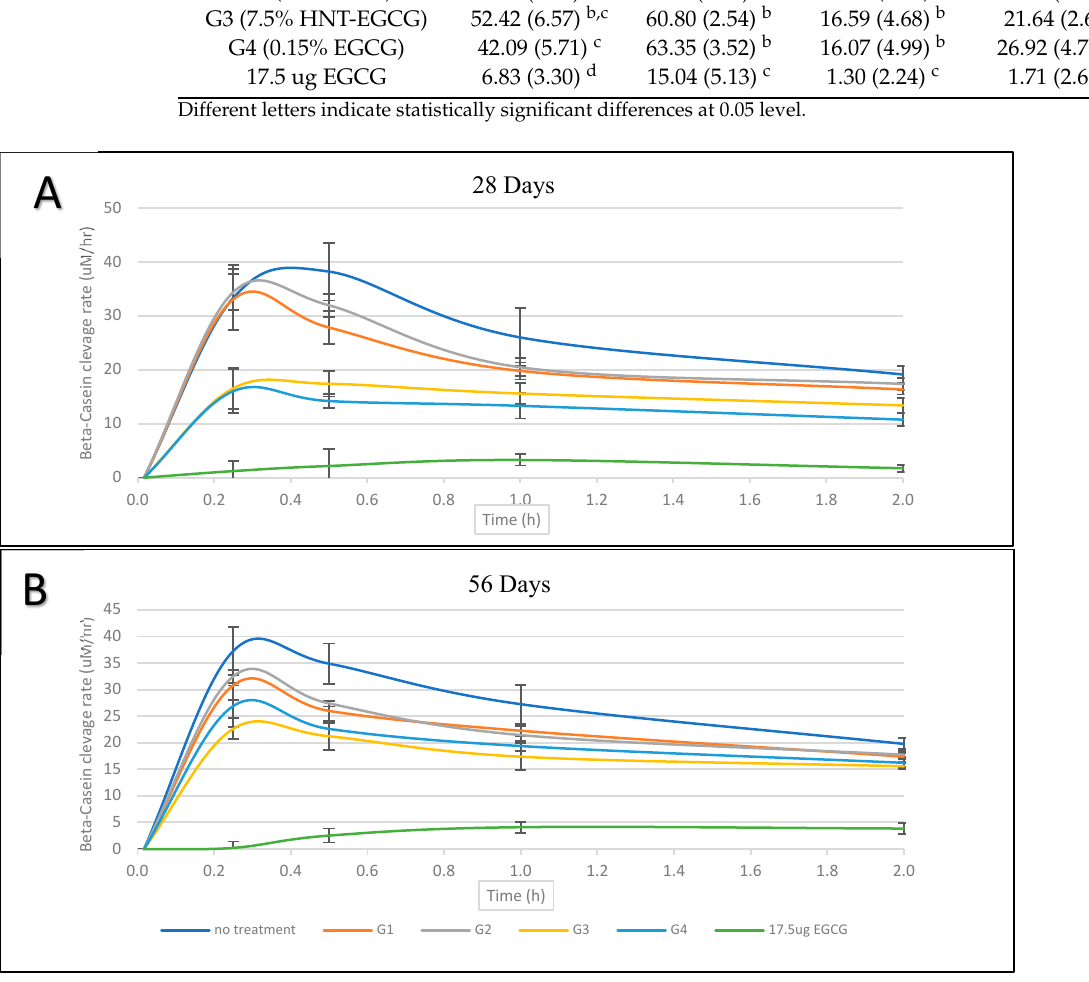
Figure 4. Total cleavage of bCN by MMP-9 detected by the intensity band relative to the baseline. 4. Discussion